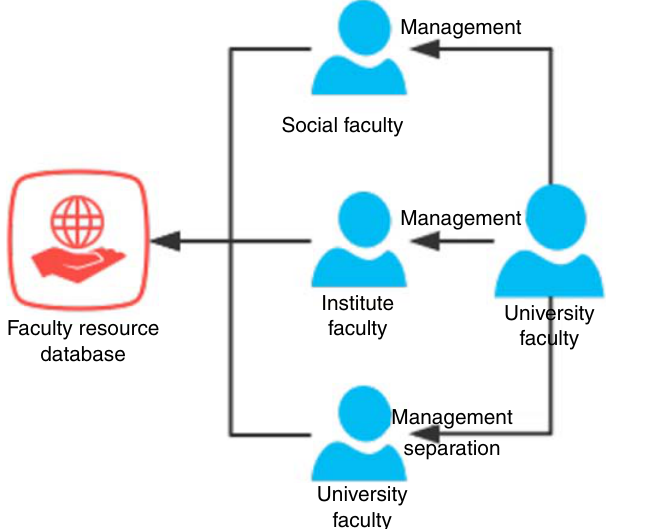
Figure 5. Composition